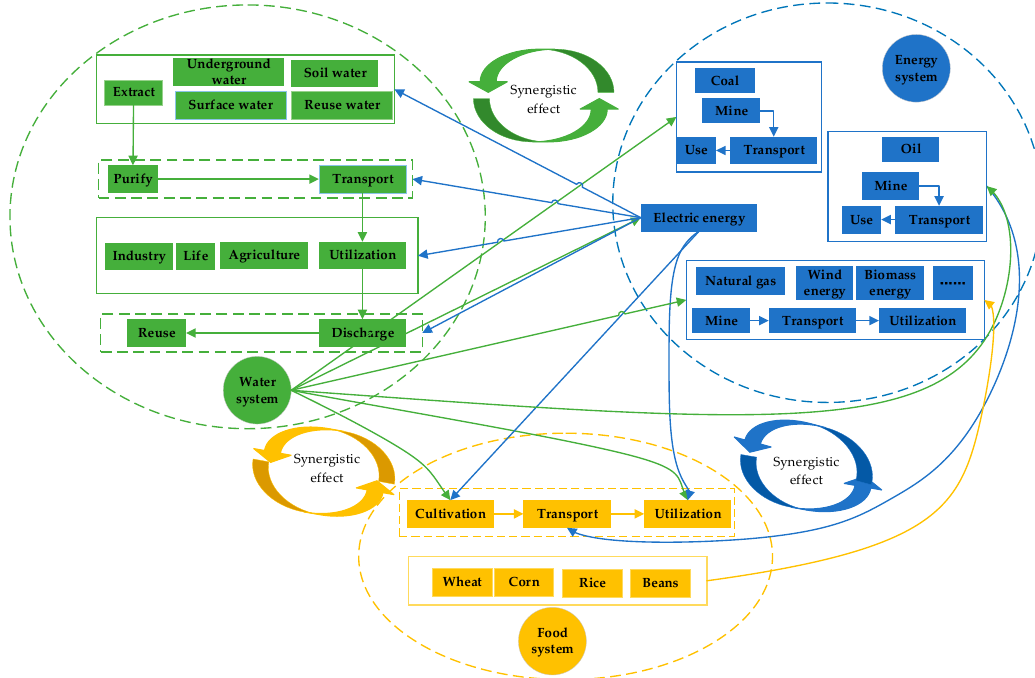
Figure 2. The framework of a regional water–energy–food system based on synergy theory in Inner Mongolia.